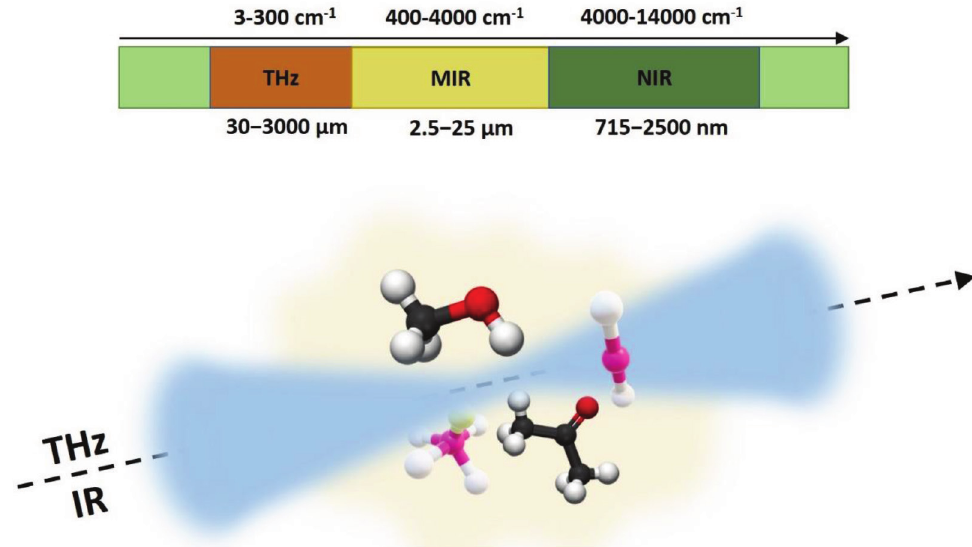
Figure 3: The interaction scheme in IR/THz vibrational spectroscopy with single- or multi-component gas mixtures. Typical frequency and wavelength ranges are shown for THz, MIR, and NIR (original